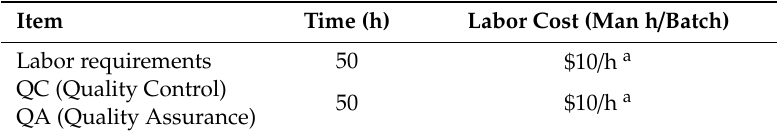
Table 4. Labor cost estimation of transamination process.